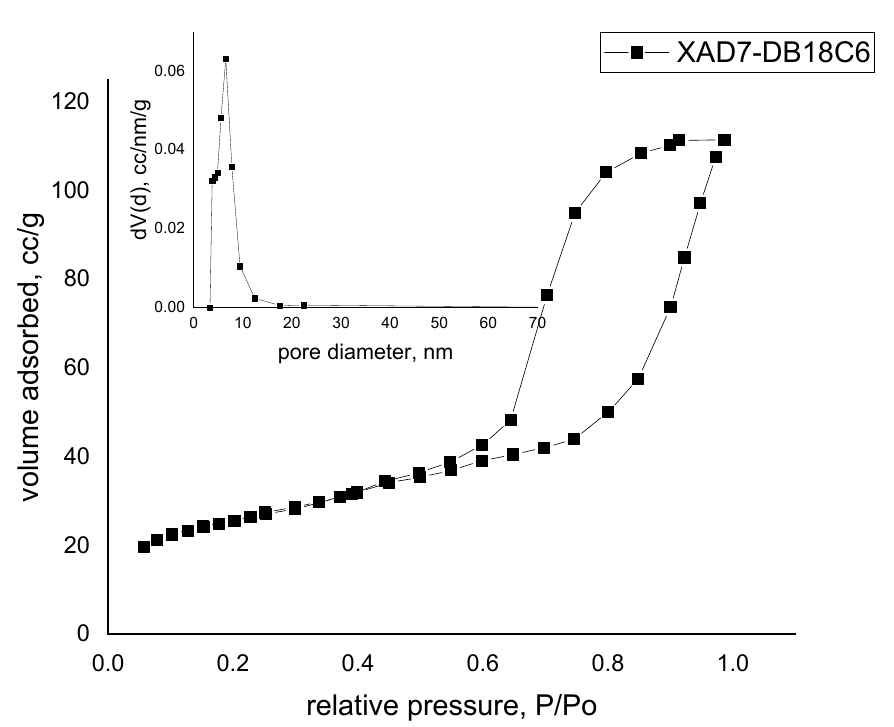
Figure 4. Brunauer–Emmett–Teller (BET) surface area.